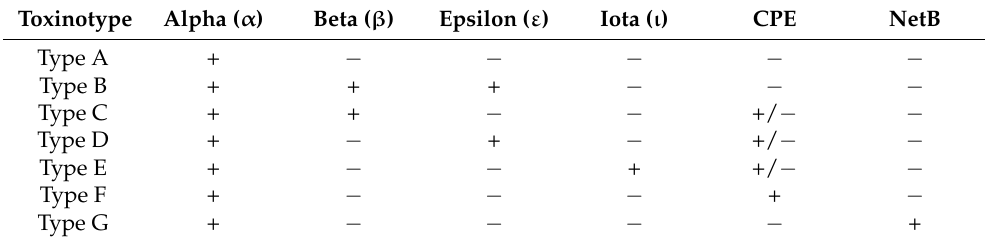
Table 1. Classification of C. perfringens based on the toxins secreted. In poultry, C. perfringens types A, C, and G are responsible for necrotic enteritis. These strains harbor different toxins/enzymes that will be discussed in the following paragraphs.